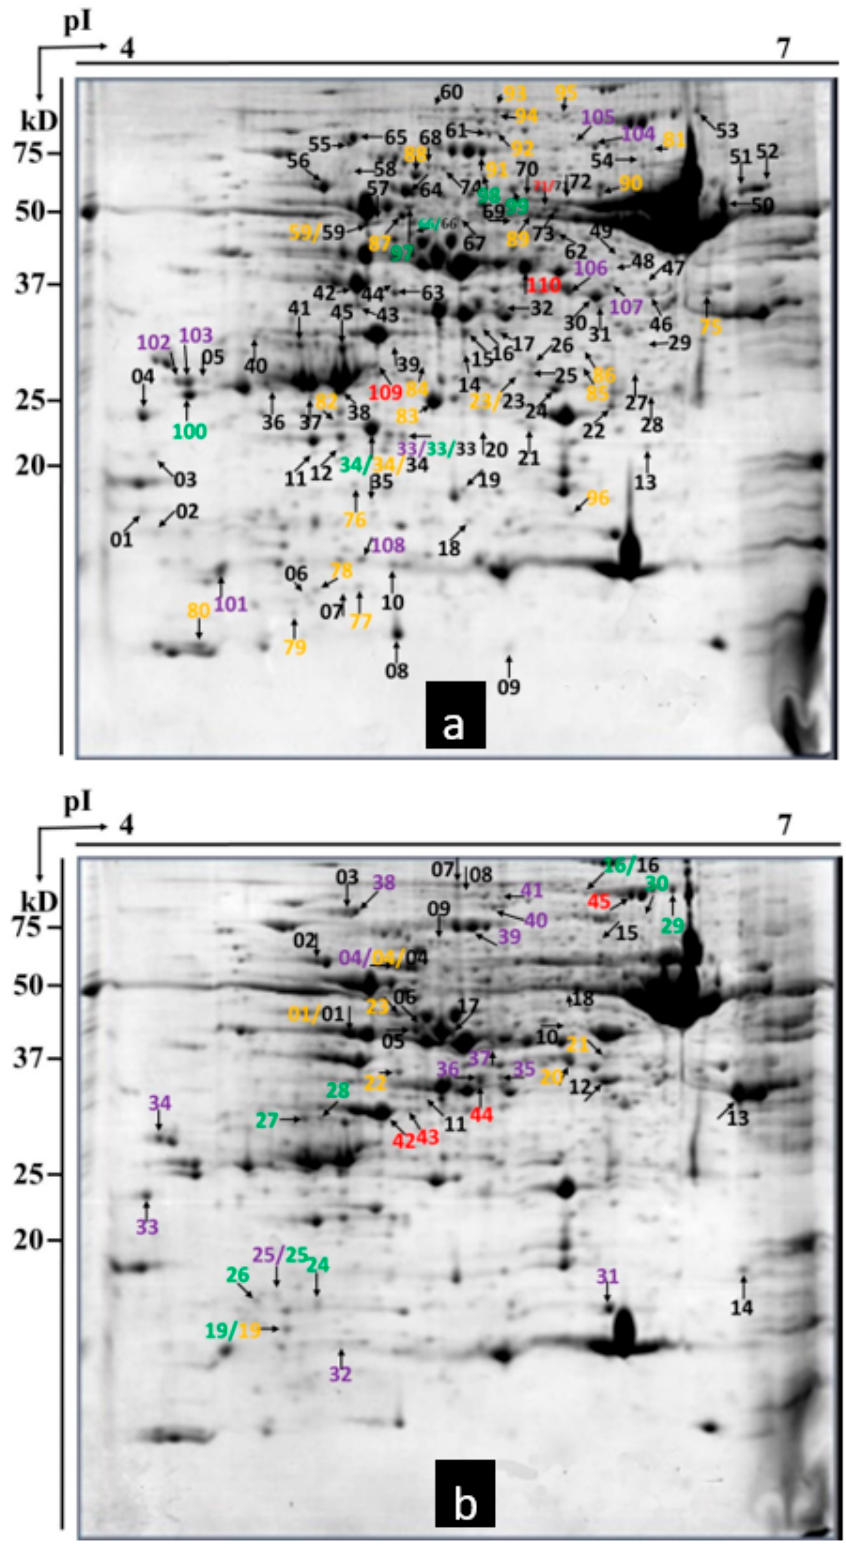
Figure 6. Differences in protein expression between susceptible wheat cultivar Chuannong26 wheat with and without powdery mildew infection. ( a ) Upregulated proteins are labeled in the representative 2-DE gel of Bgt -inoculated Chuannong26 wheat at 24 hpi. ( b ) Downregulated proteins are labeled in the representative 2-DE gel of mock-inoculated Chuangnong26 wheat at 24 hpi. Red, 2 hpi; purple, 4 hpi; green, 8 hpi; yellow, 12 hpi; black, 24 hpi).